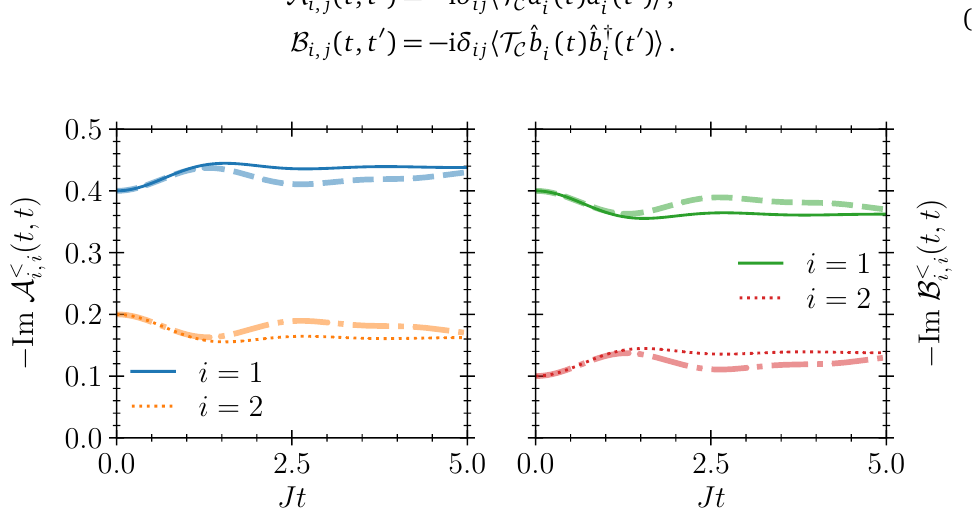
< ( t , t ) and − Im i , i A = 5 J and initial 0